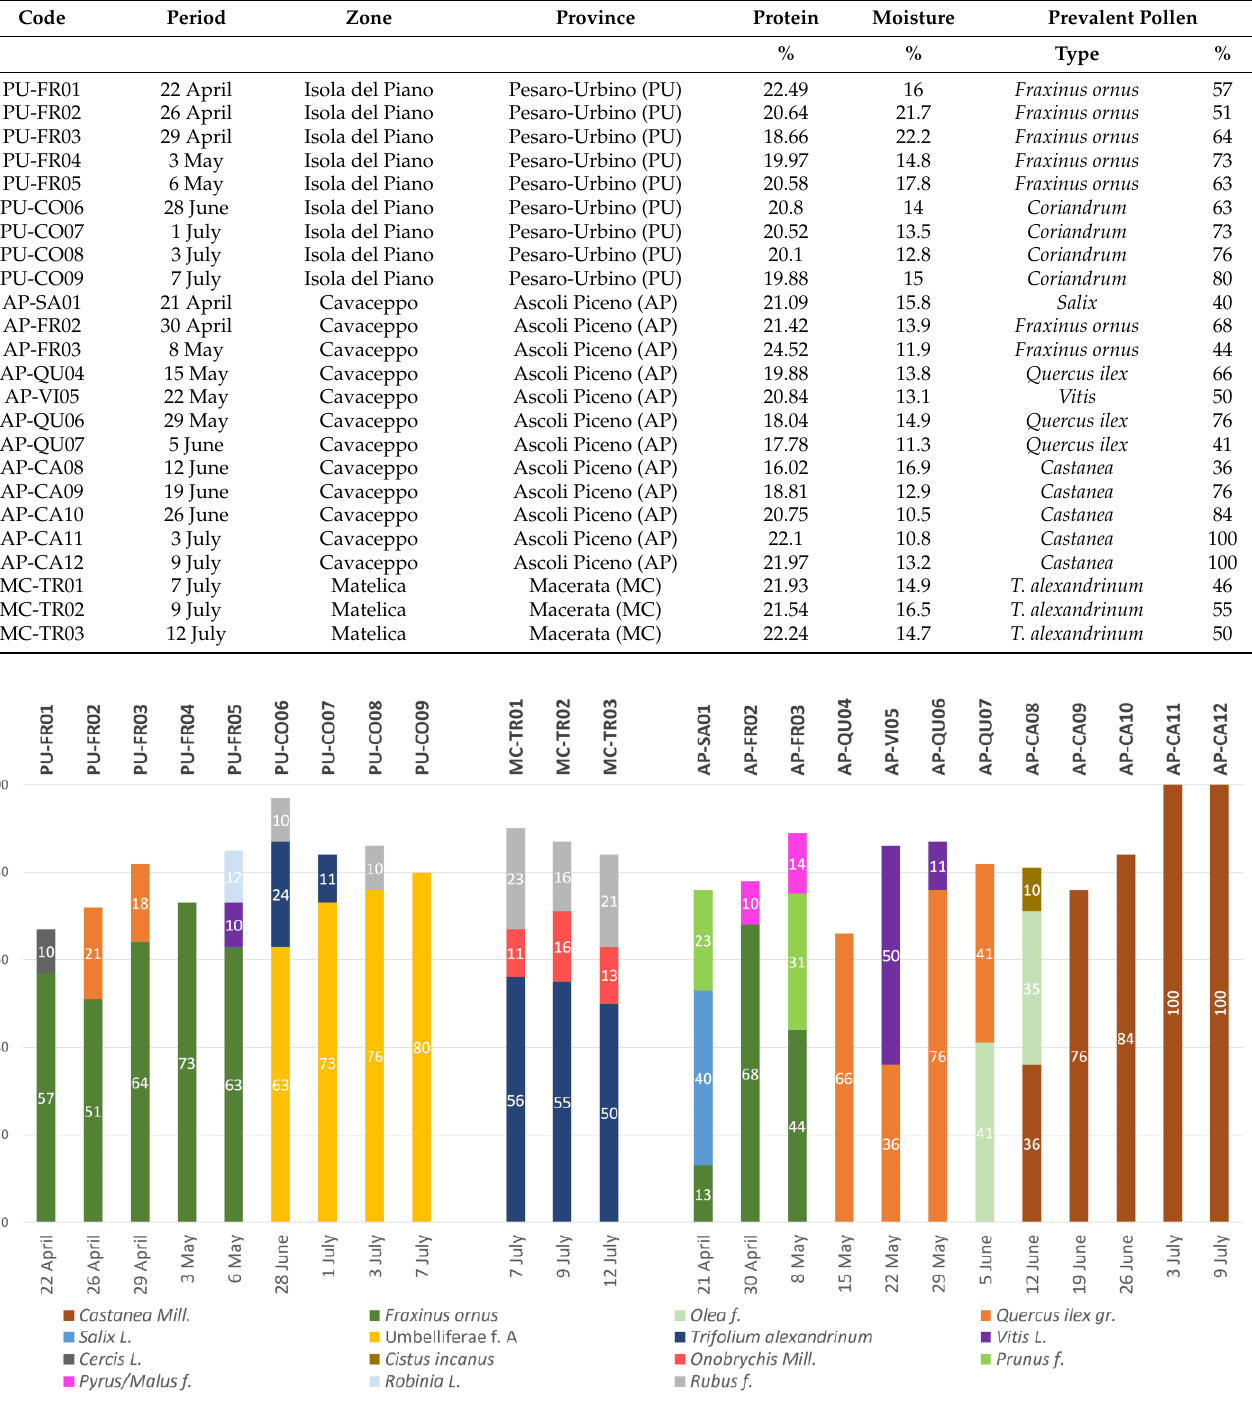
Table 1. Bee pollen samples. Zone and period of harvest, prevalent pollen and percentage, protein and moisture content (%) are described. Samples were labelled with two letters identifying the province, two letters identifying the prevalent botanical species and a consecutive number for each province.